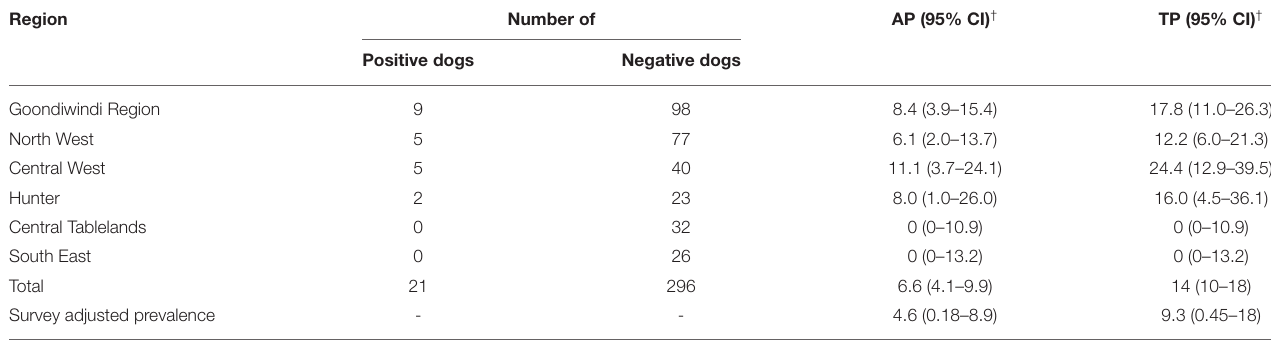
TABLE 3 | Apparent seroprevalence (AP) and true seroprevalence (TP) of Brucella suis in dogs in eastern Australia, by region, 2016 to 2019.